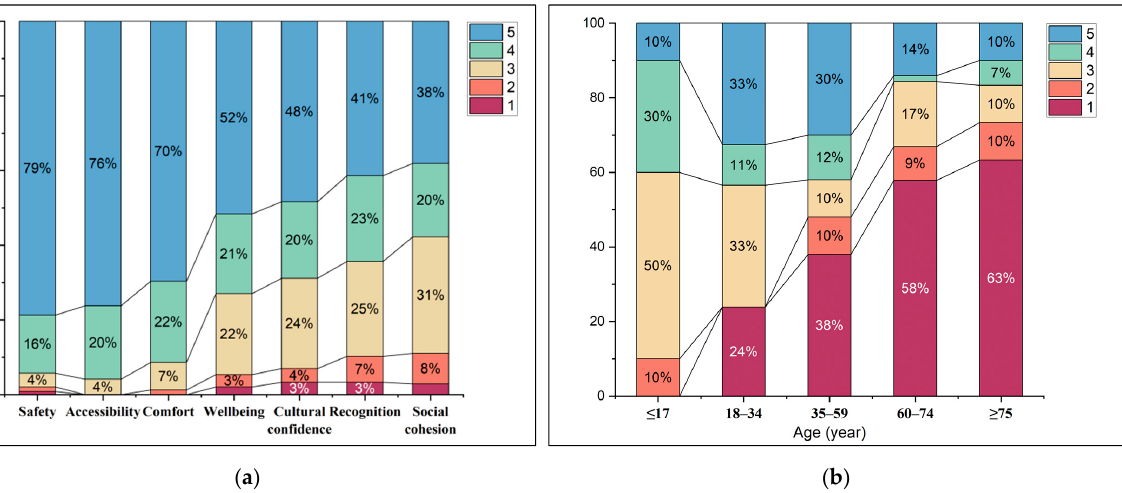
Figure 3. Residents’ satisfaction with the POSs and willingness to remain a resident in the future.